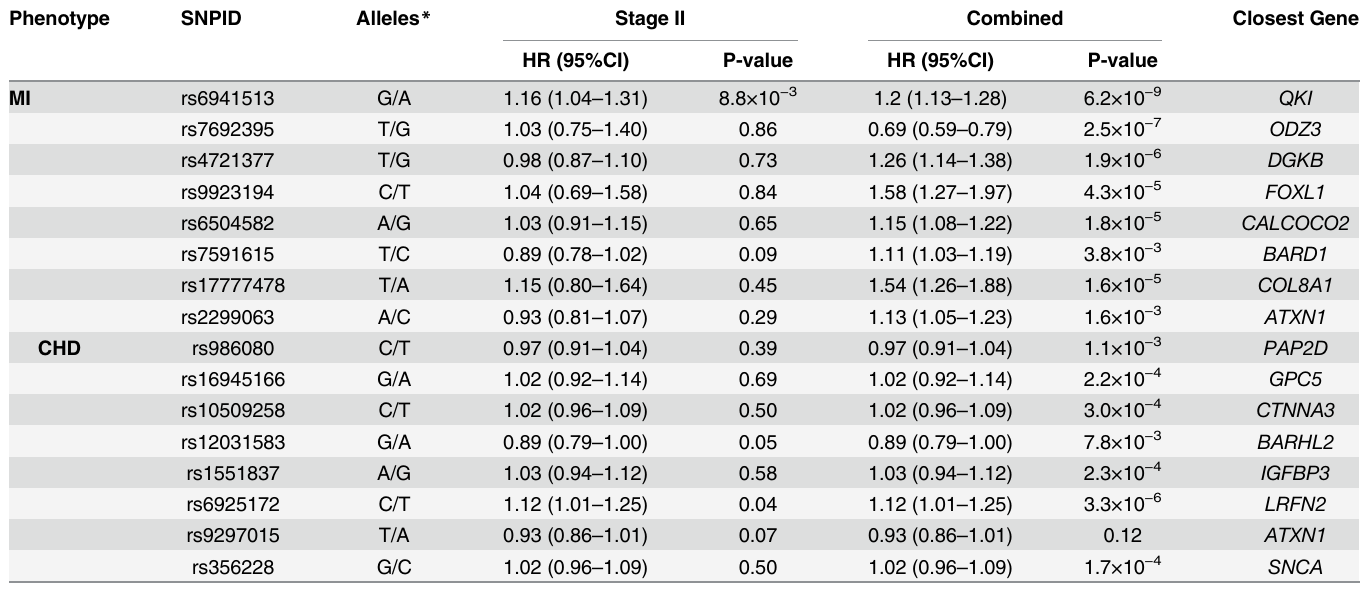
Table 3. Description and association of top SNPs with incident MI and CHD in Stage II and their combined results with Stage I.